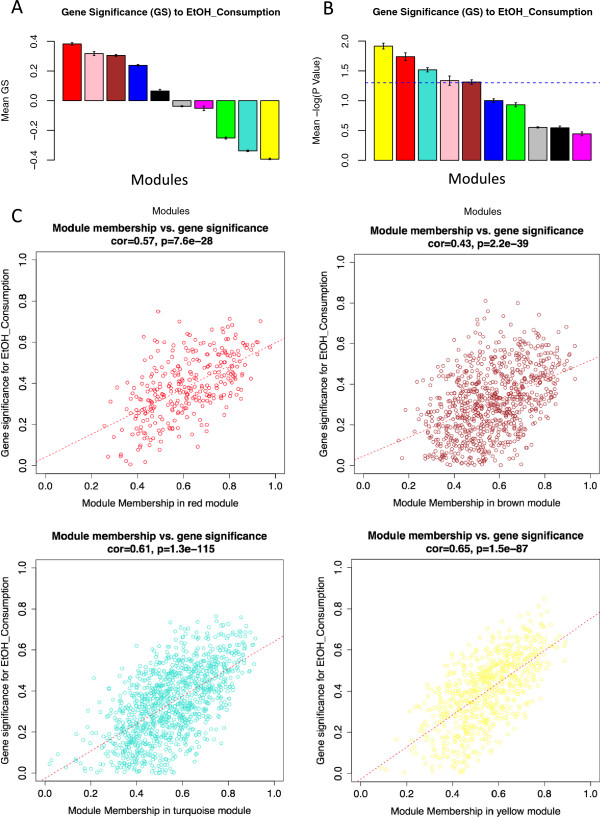
Identifying alcohol-relevant modules by average gene significance and module membership. A: Bar plot of the average gene significance for each detected module, equivalent to the average correlation among module genes and the ethanol consumption trait; B: Bar plot of the average -log P value of the gene significance; C: Plot of correlations between gene significance (GS) and module membership (MM) for representative alcohol-related modules. Color-coding is equivalent to module names. * Five modules (yellow, red, turquoise, pink, and brown) have an average P < 0.05 [-lg(P value) > 1.3].